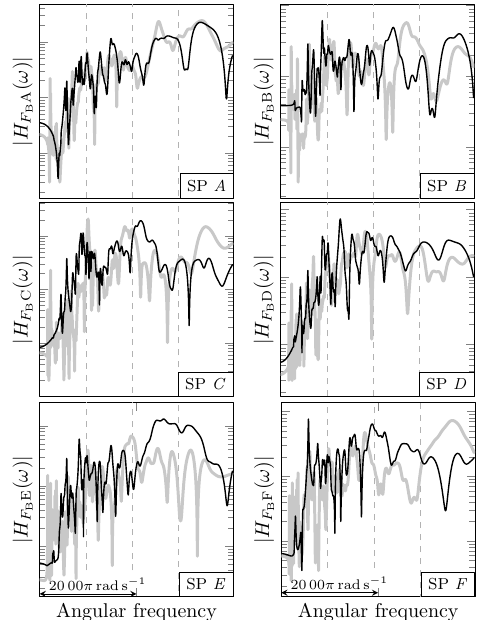
Figure 25. Influence of the internal components: Dynamic transfer functions H ( ω ) at the sensors positions A–F for an excitation by a bearing force F B , calculated with (grey) and without (black) internal components. The comparison shows significant influence of the internal components. Dashed lines indicate ω m,HS and its